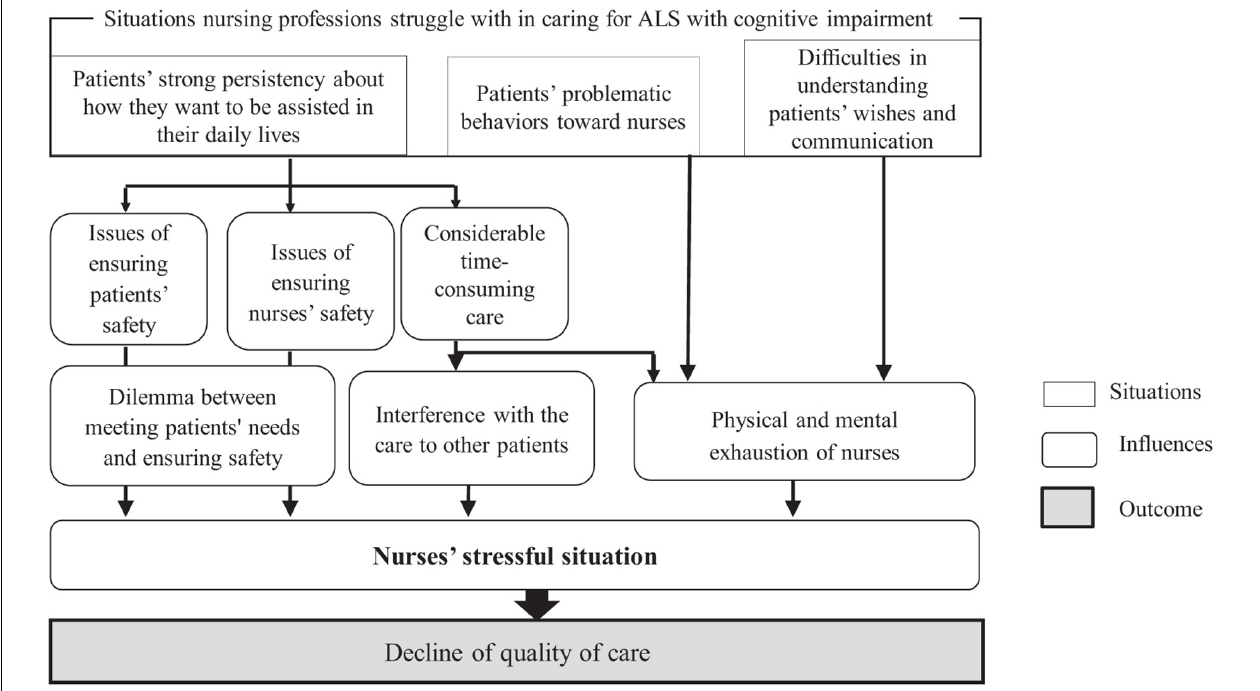
FIGURE 1 | Effects of situations nurses struggle with in caring for the patients with ALS and cognitive impairment on the quality of care.